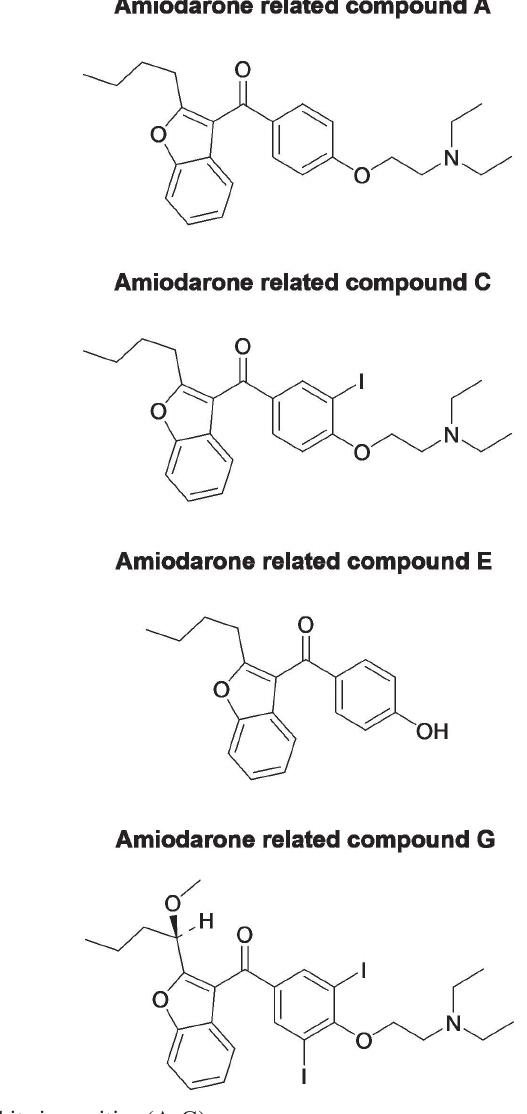
FIGURE 1 - Chemical structures of amiodarone hydrochloride and its impurities